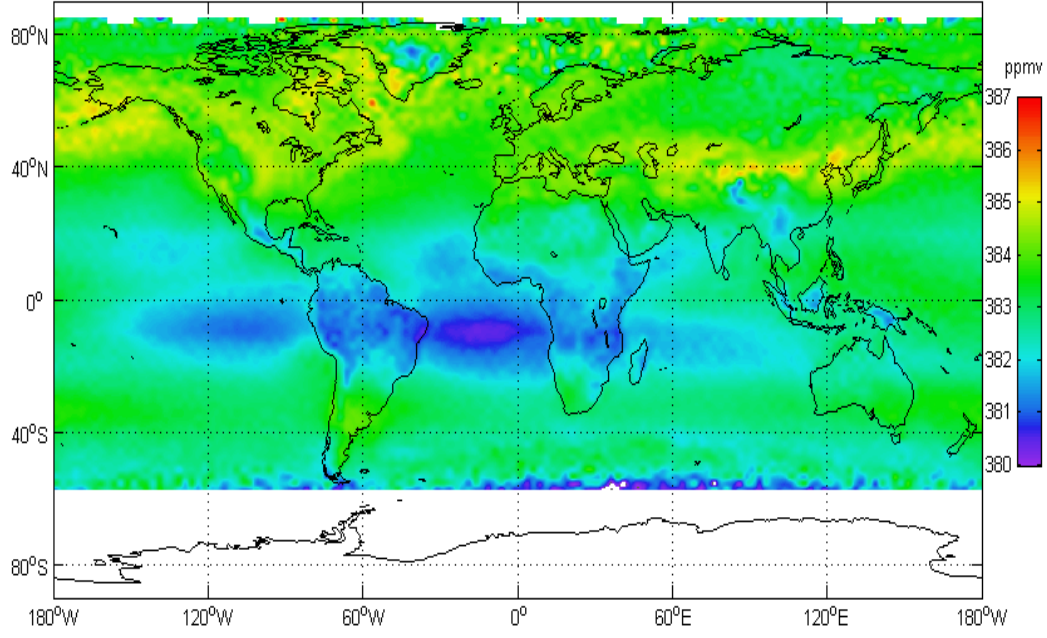
Figure 12. Global distribution map of the average of AIRS (from 6 to 8 km) annual mean XCO 2 during 2003 to 2011 after high ‐ resolution reconstruction. White regions indicate areas with no retrievals.